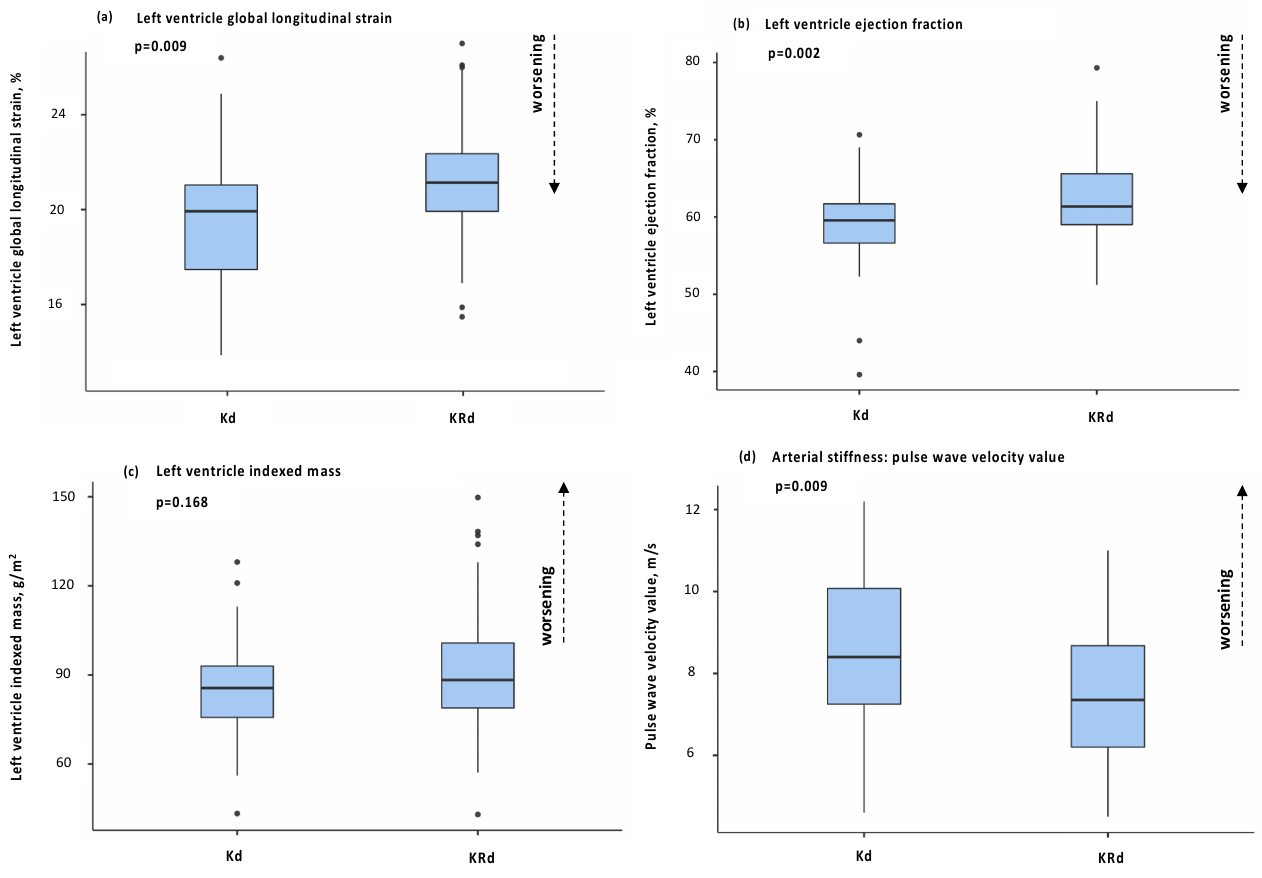
Figure 3. Box plots of main parameters of organ damage at second visit between Kd and KRd: ( a ) left ventricle global longitudinal strain; ( b ) left ventricle ejection fraction; ( c ) left ventricle indexed mass; ( d ) pulse wave velocity.